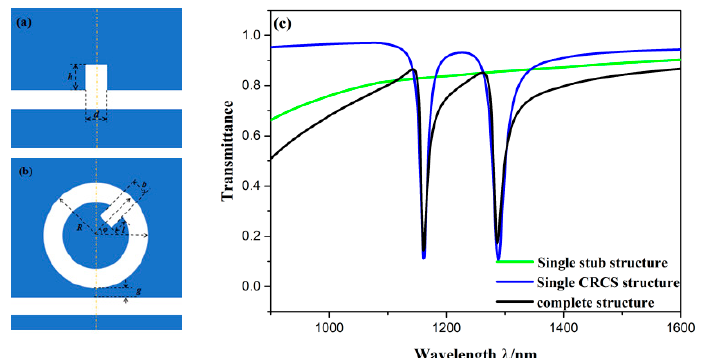
Figure 2. 2D schematic of ( a ) single stub structure; ( b ) single CRCS structure; ( c ) Transmission spectra of the single stub structure (green line), single CRCS structure (blue line), and complete structure (black line).